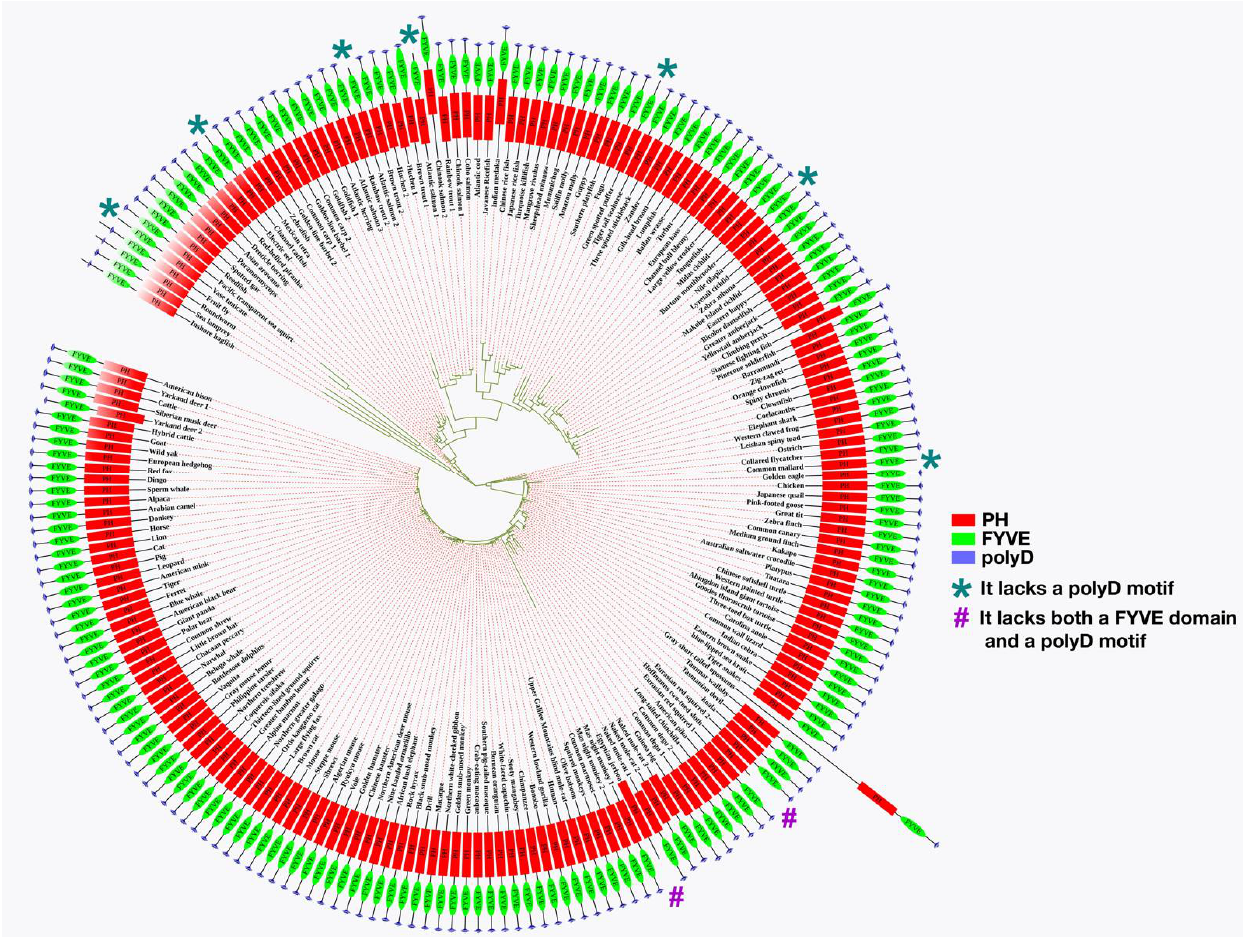
Figure 3. Phylogenetic analysis of Phafin2 homologs retrieved using the Ensembl genome browser.